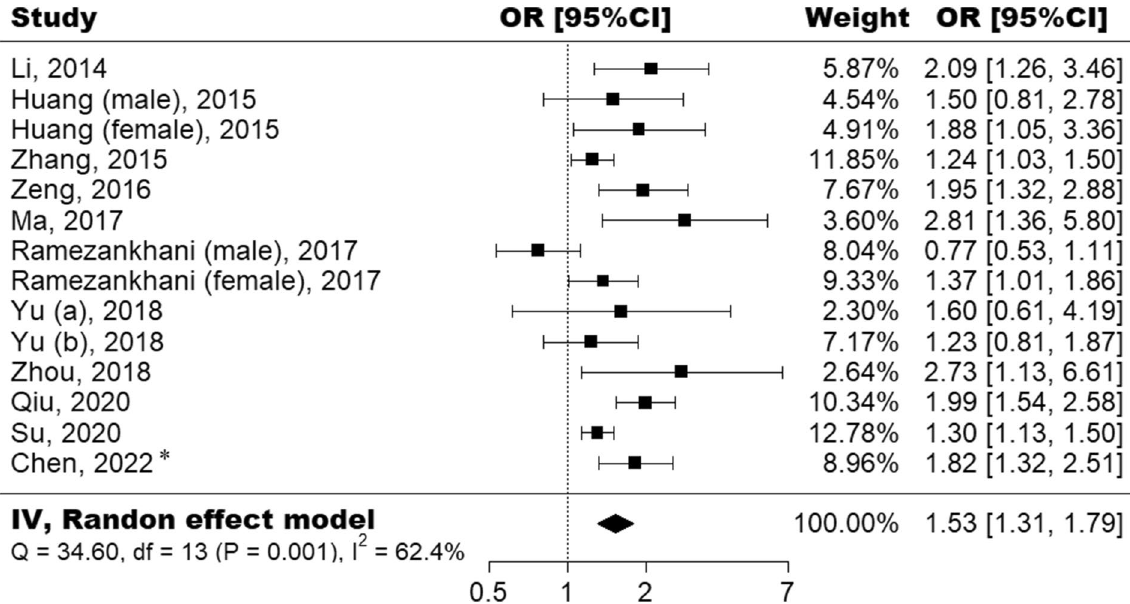
Figure 2. Forest plot summarizing the association between hypertriglyceridemic-waist phenotype and chronic kidney disease. * Data from current